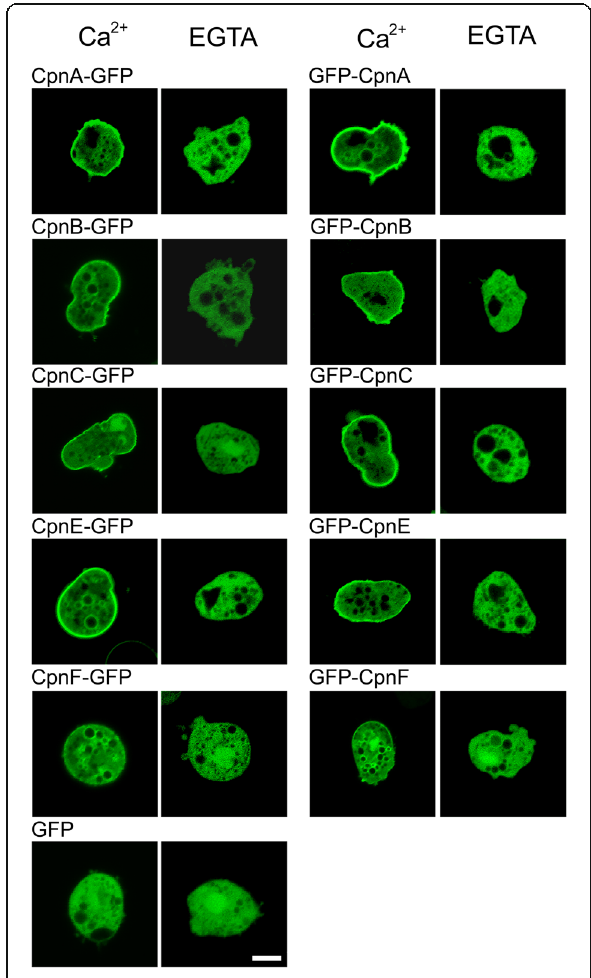
Fig. 2 GFP-tagged copine proteins translocate to membranes in live cells treated with calcium ionophore. Cells expressing GFP or a GFP-tagged copine were treated with calcium ionophore in the presence of 2 mM CaCl 2 or 5 mM CaCl 2 for CpnF (Ca 2+ ) or 5 mM EGTA (EGTA). Images were obtained with a Nikon Eclipse Ti inverted laser scanning confocal microscope using a 60× oil immersion objective. Representative images are shown for each copine cell line. Scale bar = 5 μ